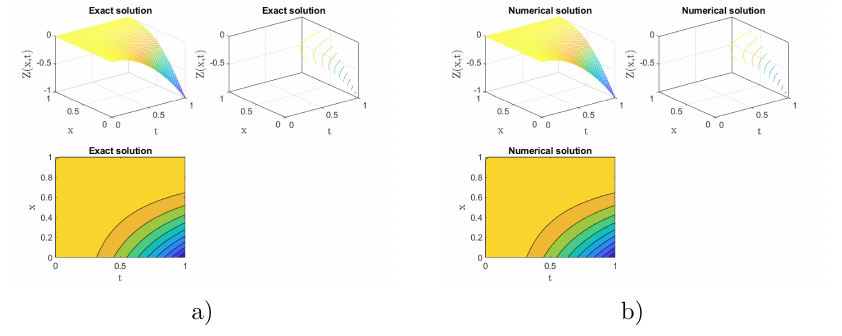
Figure 5. The exact solution ( a ) and approximate solution ( b ) with m = m ′ = 1, M = M ′ = 4 and η = η 1 = 1 for Example 2. 2 Plots of absolute error functions of approximate solutions for M = M ′ = 32, M = M ′ = 64 and η = η 1 = 1 has been reported in Figure 6. 2